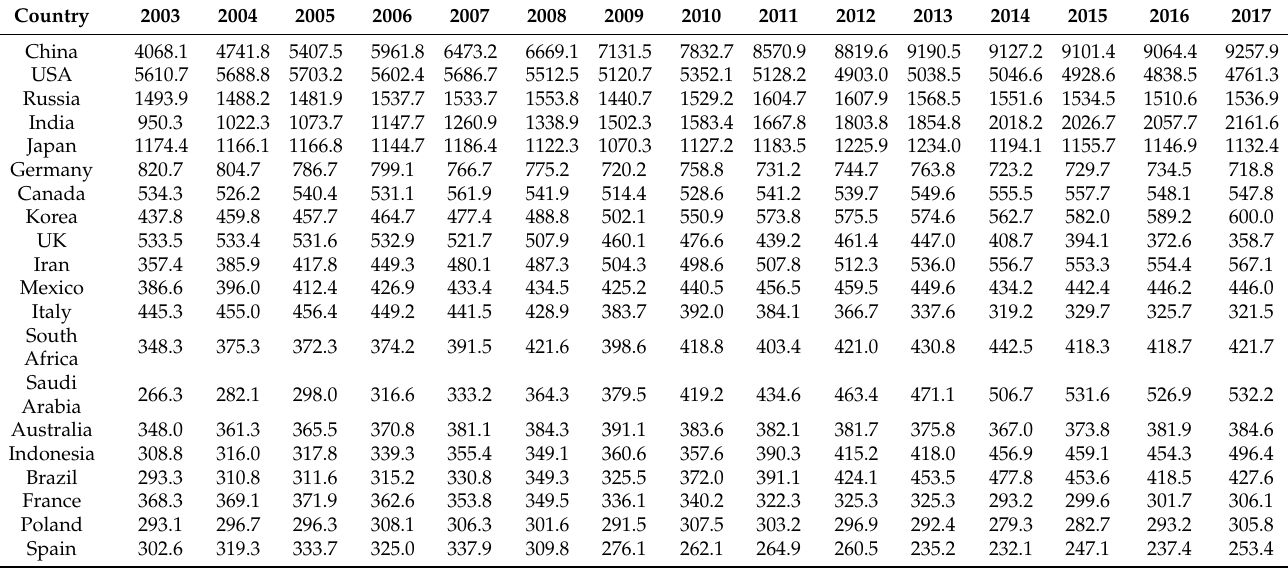
Table 1. Historical annual carbon dioxide emission from top twenty countries (unit: million tons).